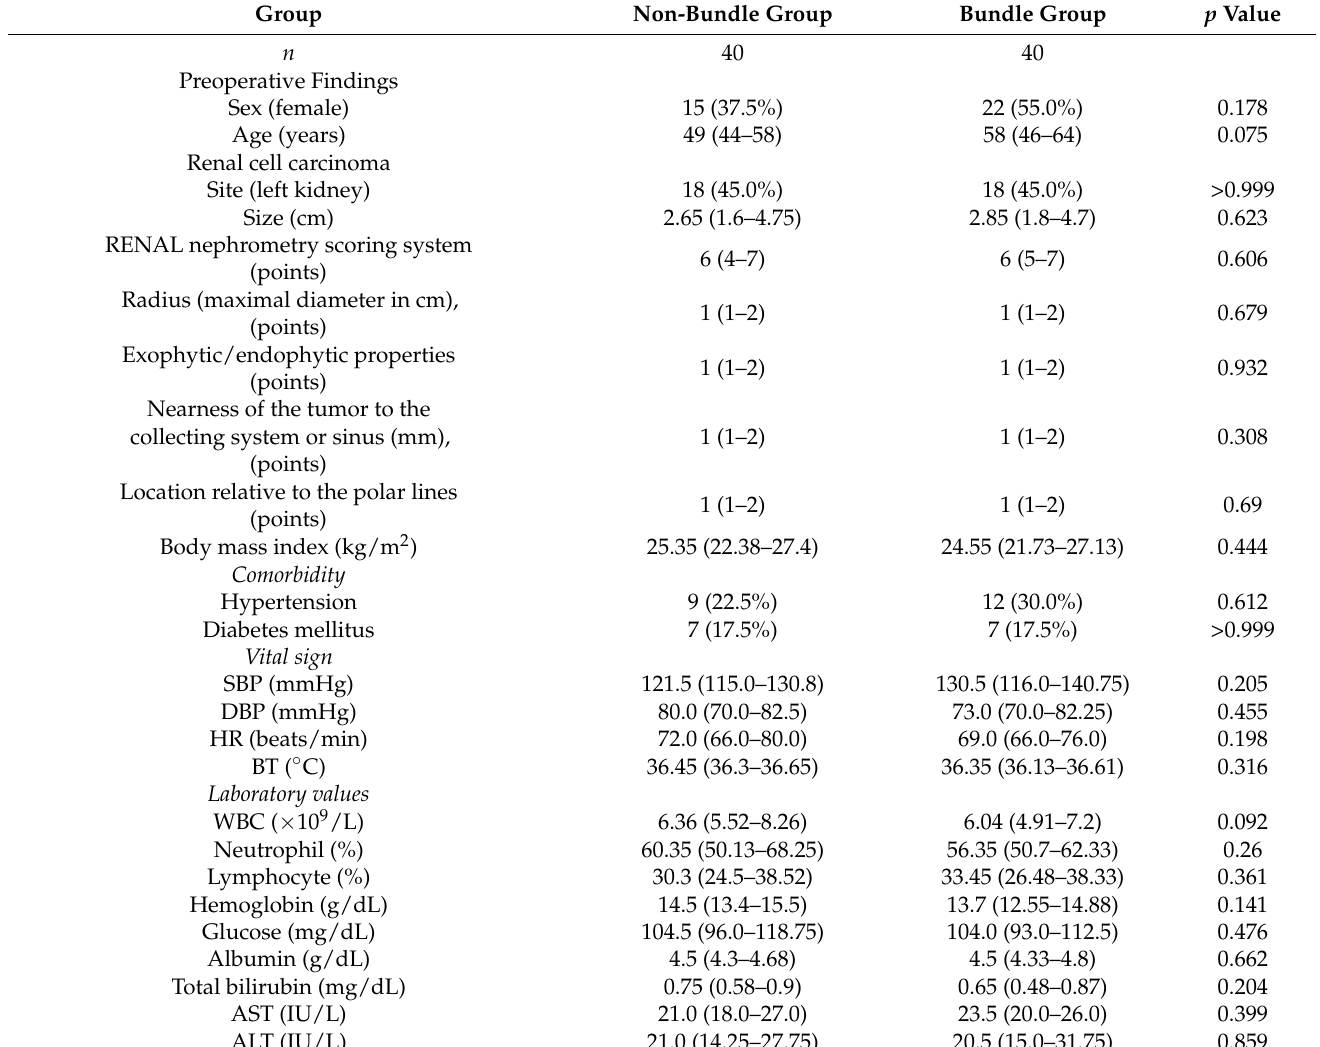
Table 1. Comparison of pre- and intraoperative findings between the two